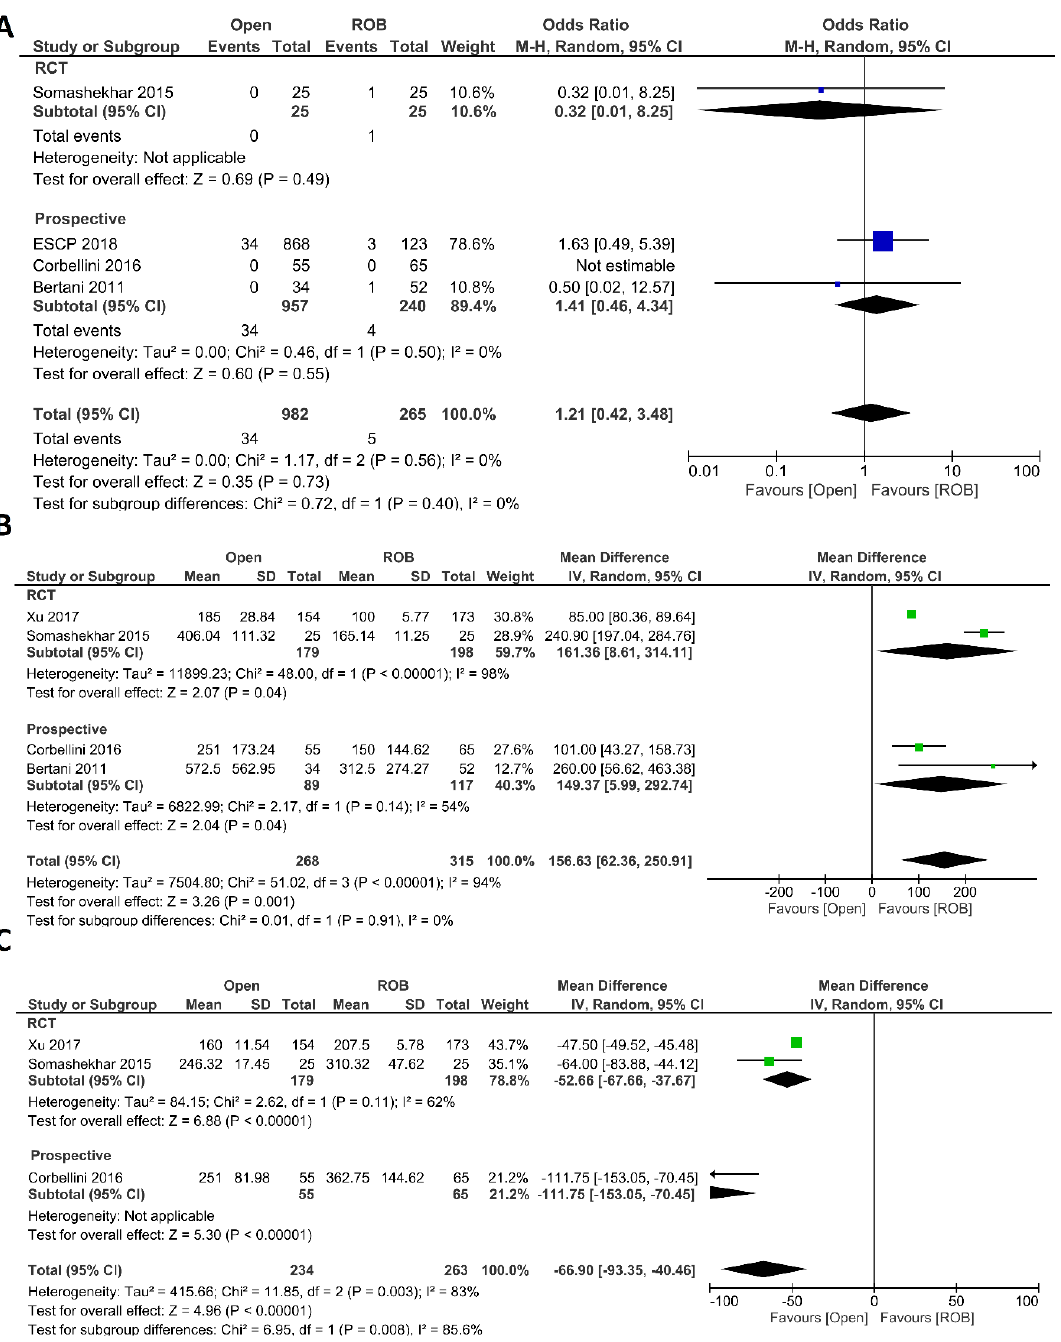
Figure 2. Forest plots comparing ( A ) intraoperative complications [18,20,44,46], ( B ) estimated blood loss [18,20,40,46], and ( C ) operation time [18,20,40] between robotic and open rectal resection (blue boxes representing odd ratios, green boxes representing mean differences, arrows repre- senting 95% confidence intervals, and diamonds representing point estimates of pooled odd ratios or mean differences).